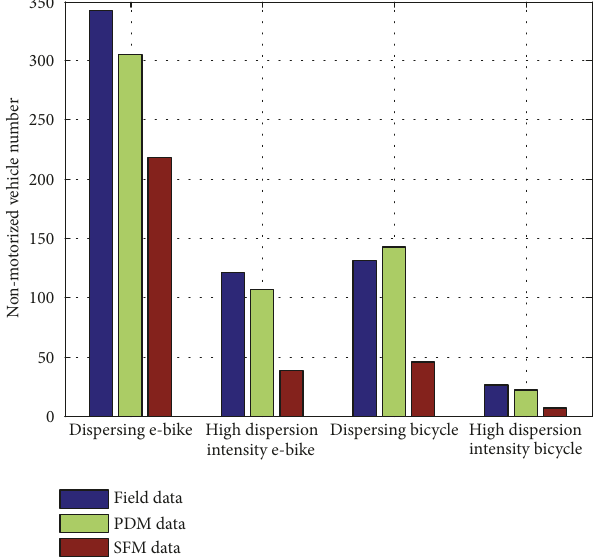
Figure 15: Number of dispersing nonmotorized vehicles at the Xianxia-Jianhe